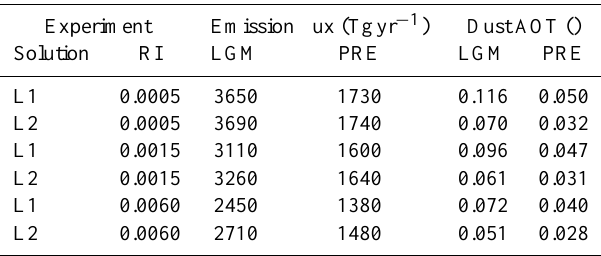
Table 4. Impact of dust DRF on global dust emission flux and dust AOT from six simulation experiments using solutions L1 and L2 and low, medium and high imaginary refractive index (RI) calcu- lated at 21ka (LGM) and 0ka (PRE).